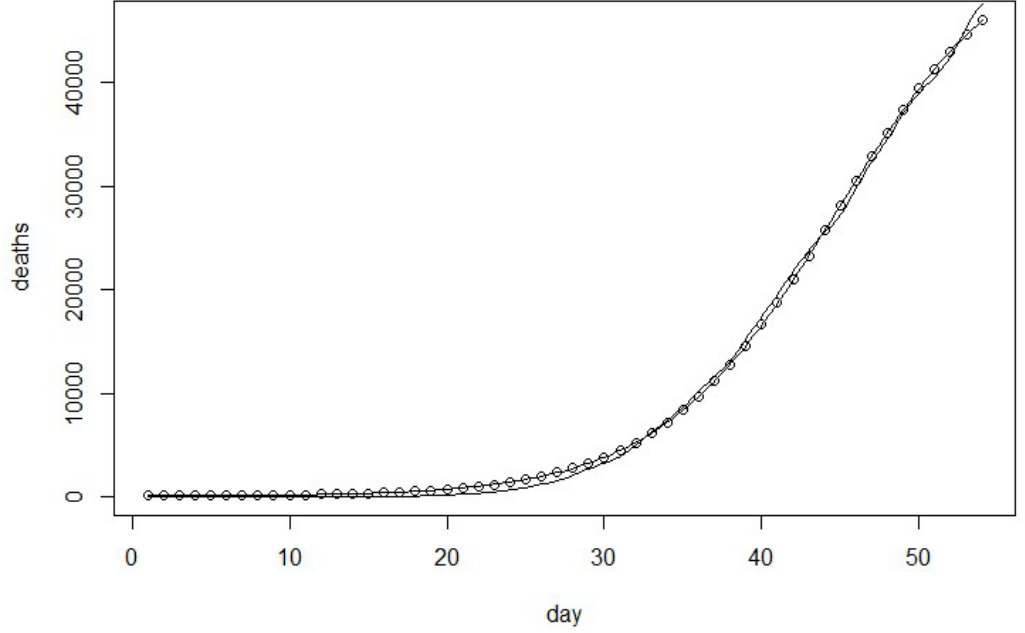
Figure 1. The estimated cumulative number of deaths vs. actual death data from Model 1.